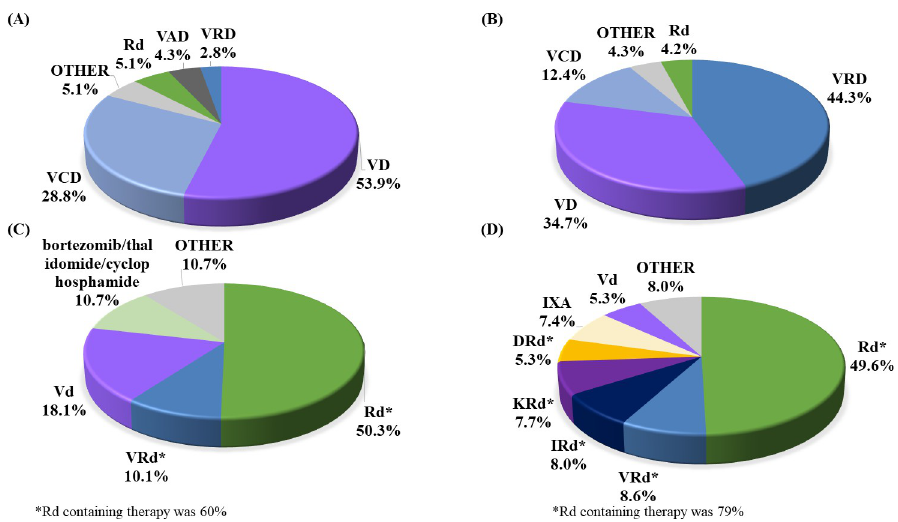
Fig 2. Regimen selection for induction therapy before SCT and post-SCT therapy in the SCT-conducted group. ( A ) 2003 to 2015 induction therapy before SCT, ( B ) 2016 to 2020 induction therapy before SCT, ( C ) 2003 to 2015 post- SCT therapy, ( D ) 2016 to 2020 post-SCT therapy. DRd, daratumumab/lenalidomide/dexamethasone; IRd, ixazomib/ lenalidomide/dexamethasone; IXA, ixazomib; KRd, carfilzomib/lenalidomide/dexamethasone; Rd, lenalidomide/ dexamethasone; SCT, stem cell transplantation; VAD/VAd, vincristine/doxorubicin/dexamethasone; VCD/VCd, bortezomib/cyclophosphamide/dexamethasone; VD/Vd, bortezomib/dexamethasone; VRD/VRd, bortezomib/ lenalidomide/dexamethasone. Note: Post-SCT therapy is the initiation date of the regimen between the date of SCT and post 4 months from SCT.